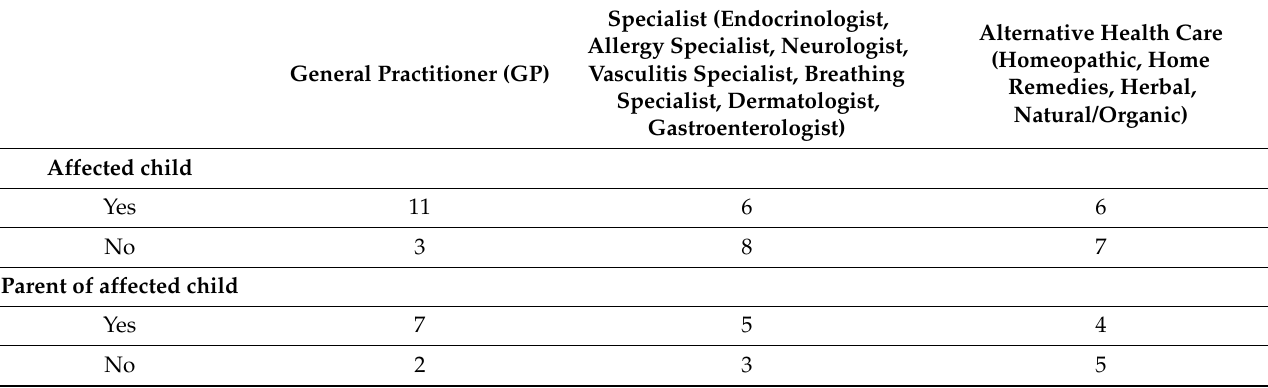
Table 2. Type of regular health care